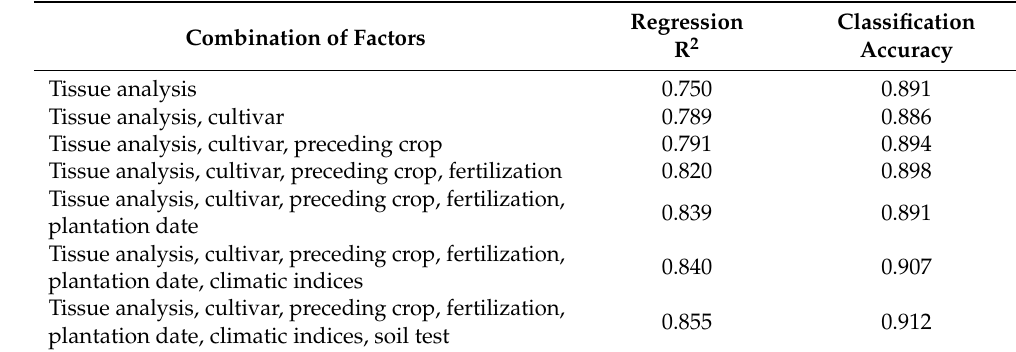
Table 2. Accuracy of the Adaboost in regression mode and random forest in classification mode for the garlic training dataset collected in 2015–2017.